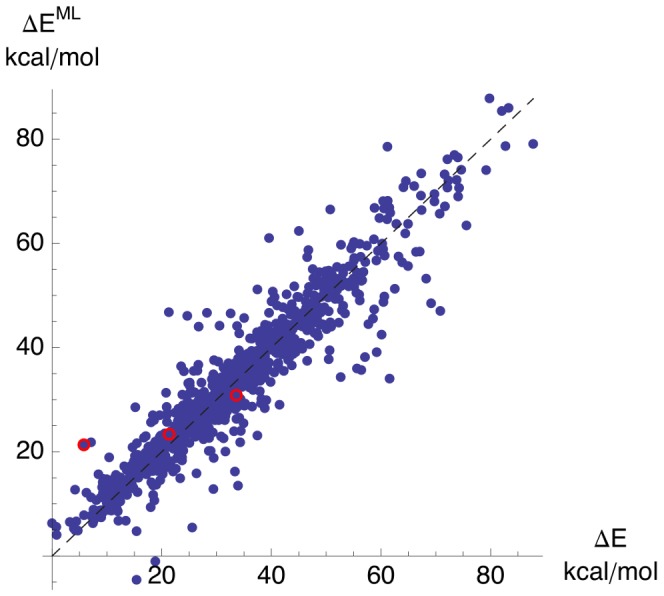
Predicted  vs calculated ΔE values of Archazolid A conformations.All predictions were obtained by stratified 10-fold cross-validation of the complete MD data. NMR-based conformations c5a, c5b, nmr are marked by red circles (external test data).